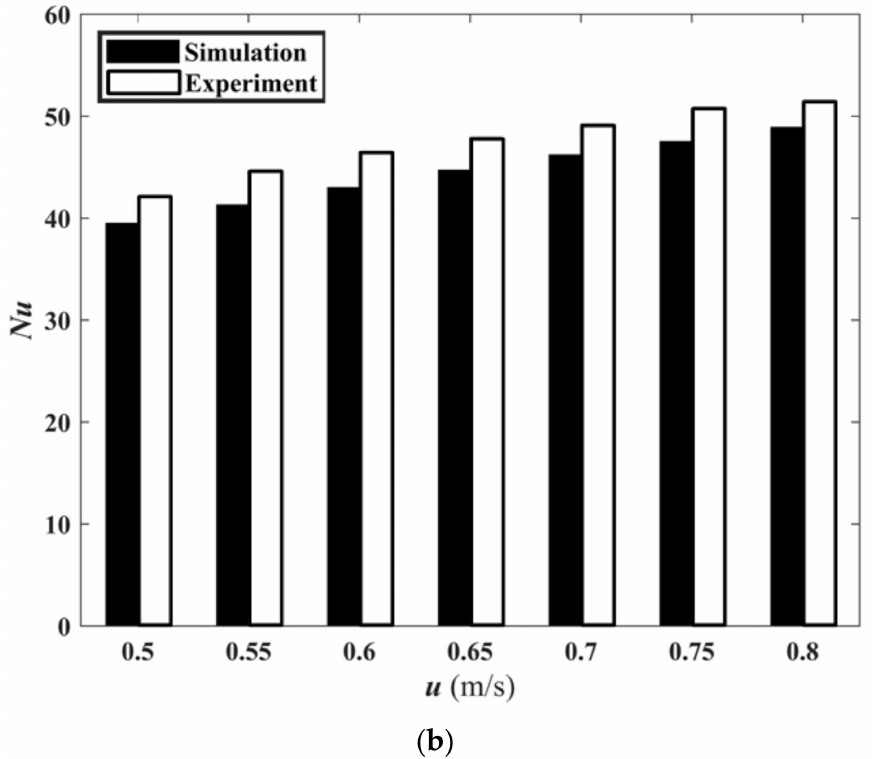
Figure 19. Experimental and simulation results. ( a ) The ∆ P sim and ∆ P exp of M1 with flow rate; ( b ) Simulated Nusselt number and experimental Nusselt number of M1 with flow